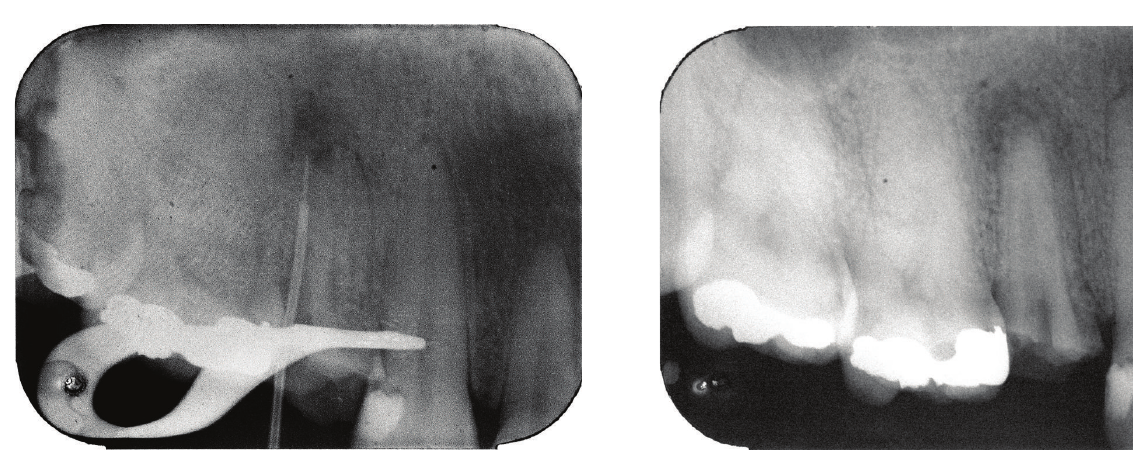
Figure 5: Periapical radiograph confirming the complete removal of the fragment.